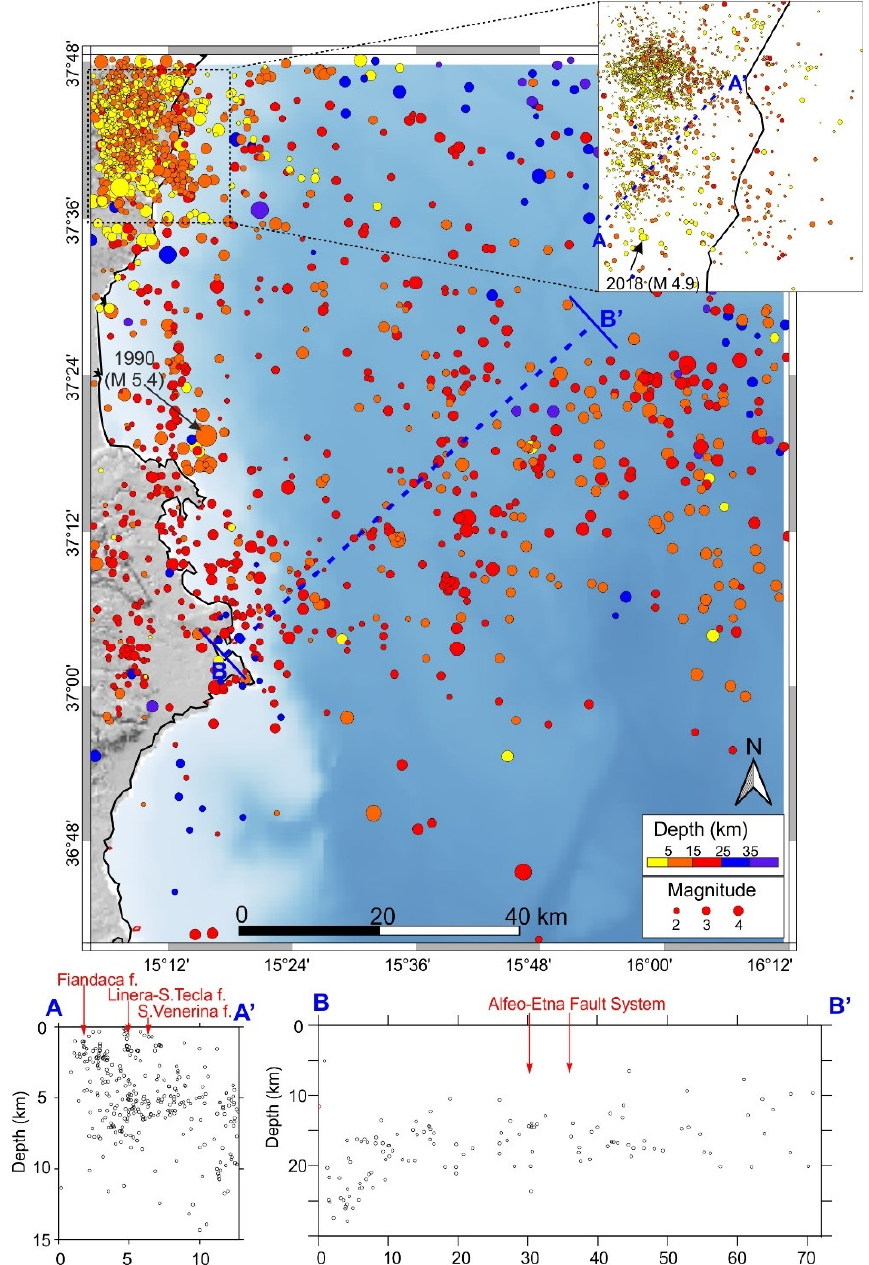
Figure 11. Final location on the map and the vertical sections of the last 40 years seismic events (see text). Cross sections (marked in map) incorporate all relocated events within ±3 km ( AA’ ) and ±6 km ( BB’ ) from the cross-section lines.